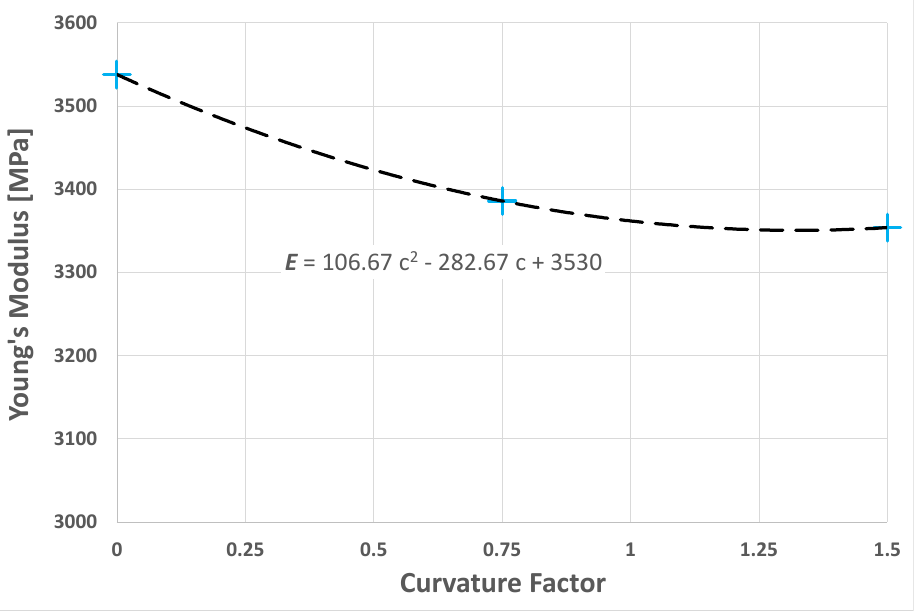
Figure 13. Graph of the Young’s modulus of the composite as the mean curvature factor of the fibers varied in an RVE with V f = 0.1.